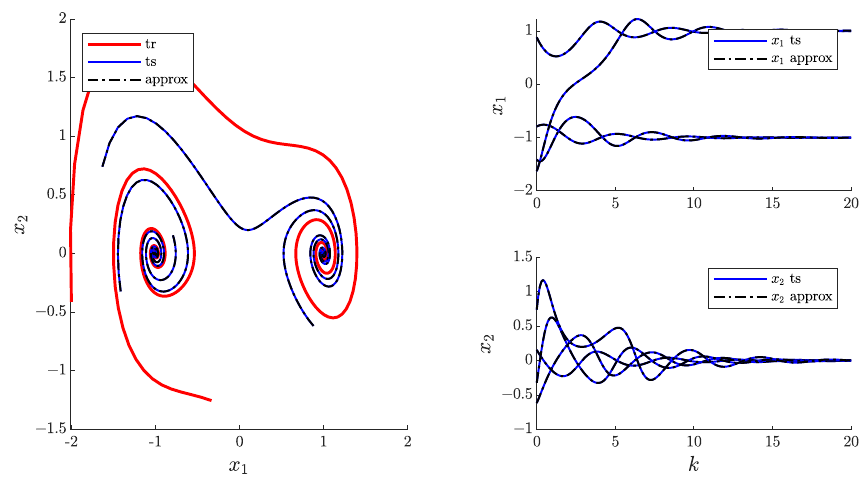
Figure 3. pqEDMD approximation for the soft damping Duffing oscillator.